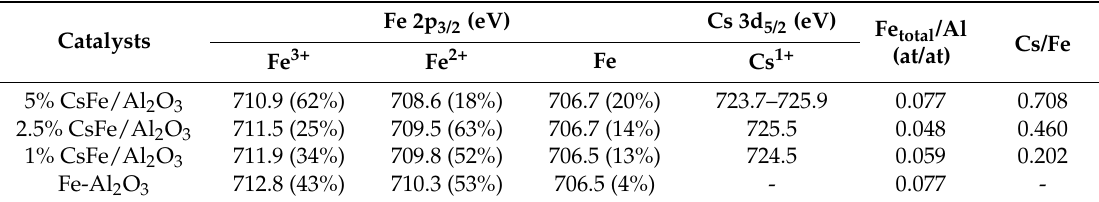
Table 2. Binding energies of the Fe 2p 3/2 and Ce 3d 5/2 levels for the pre-reduced catalysts and Fe/Al atomic ratios.